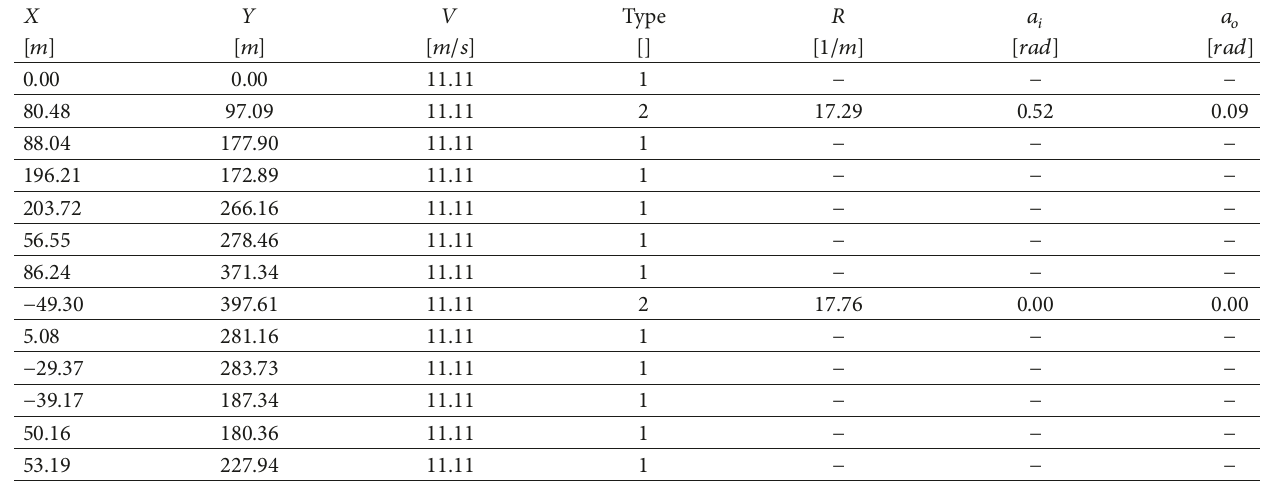
Table 3: Point description of the map used for global